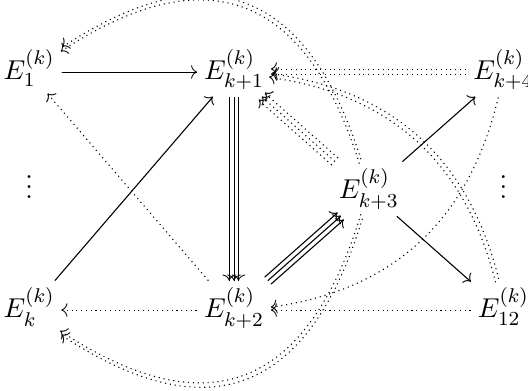
Figure 1 . The quiver of the endo-algebras A ( k ) derived equivalent to the category of coherent sheaves on a rational elliptic surface with